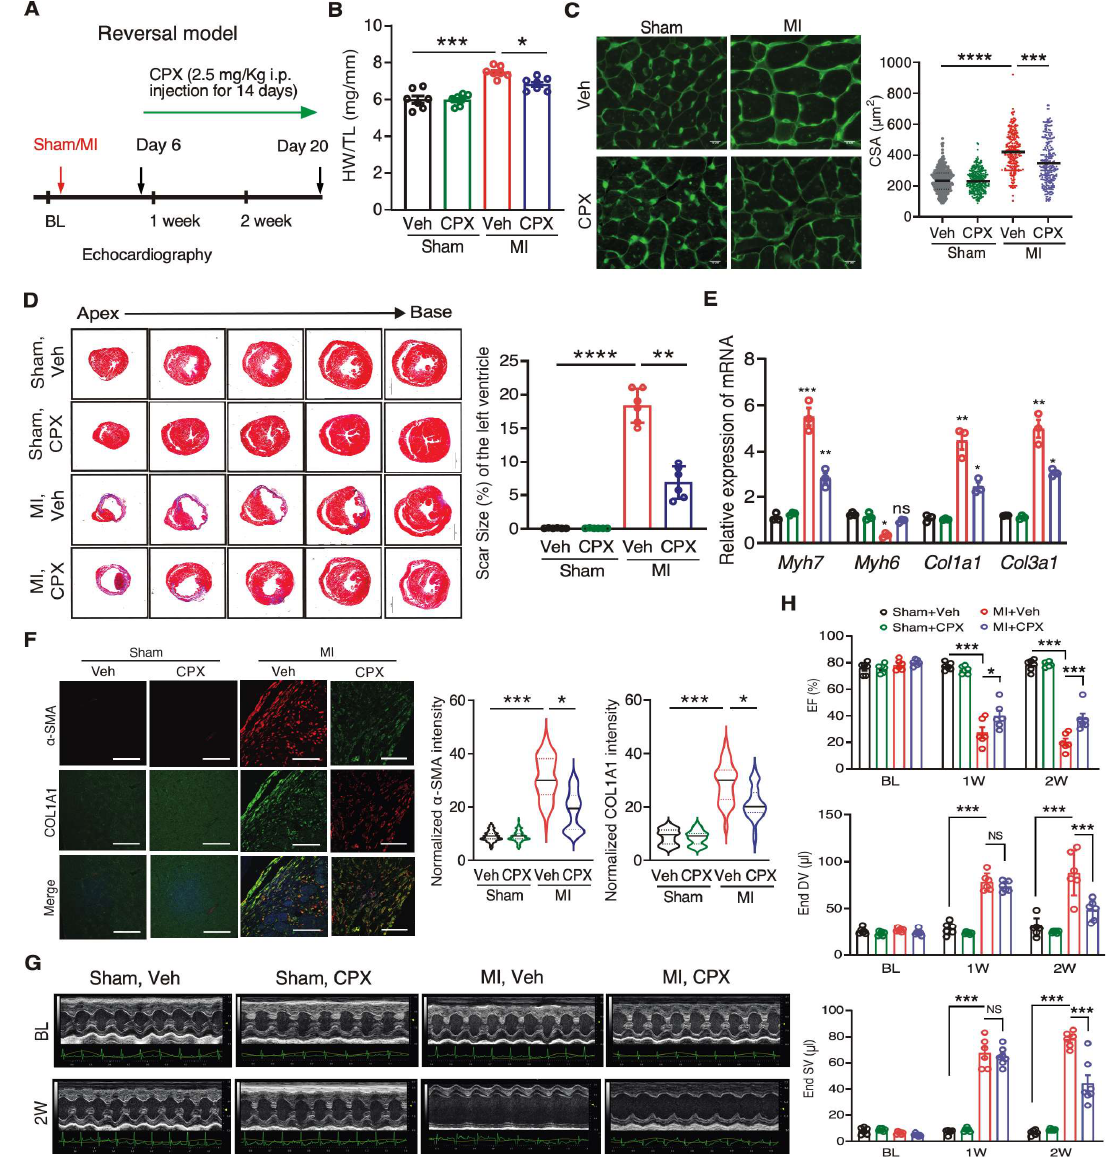
Figure 4. Ciclopirox reduces cardiac remodeling and fibrosis after MI in a reversal model. ( A ) Schematic of a reversal model using CPX to treat MI in mice. ( B ) Reduced HW/TL ratio in 3-week MI mouse HF model compared to vehicle-treated mice. n = 7 for the four groups of Veh Sham/CPX Sham/Veh MI/CPX MI. ( C ) Wheat germ agglutinin staining of the vehicle and CPX-treated mice with sham or MI surgery. The cross-sectional area (CSA) of CMs was measured and quantified. n = 6 hearts per group with 250–300 CMs measured per heart. Scale bar: 10 µ M. ( D ) Trichrome blue staining indicates a decreased fibrotic area in the hearts of CPX-treated mice after MI surgery. Scale bar: 1 mm. n = 6 for all the groups. ( E ) RT-qPCR measurement of expression of cardiac hypertrophy and fibrosis marker mRNAs. 18S rRNA was used as a normalizer. n = 3 for all the groups. ( F ) α -SMA and COL1A1 protein expression in heart tissues of CPX-treated mice with MI surgery. n = 5 hearts per group with >300 CFs measured per heart. Scale bar: 50 µ M. ( G ) Representative echocardiographic images of the vehicle and CPX-treated mice after sham or MI surgery. ( H ) Ejection fraction (EF) was partially recovered, and end systolic and diastolic volumes were reduced in CPX-treated mice in MI surgery-induced mouse HF model. n = 6 for the four groups of Veh Sham/CPX Sham/Veh MI/CPX MI. * p < 0.05, ** p < 0.01, *** p < 0.001, **** p < 0.0001, ns: not significant by Two-way ANOVA with Tukey’s multiple comparisons